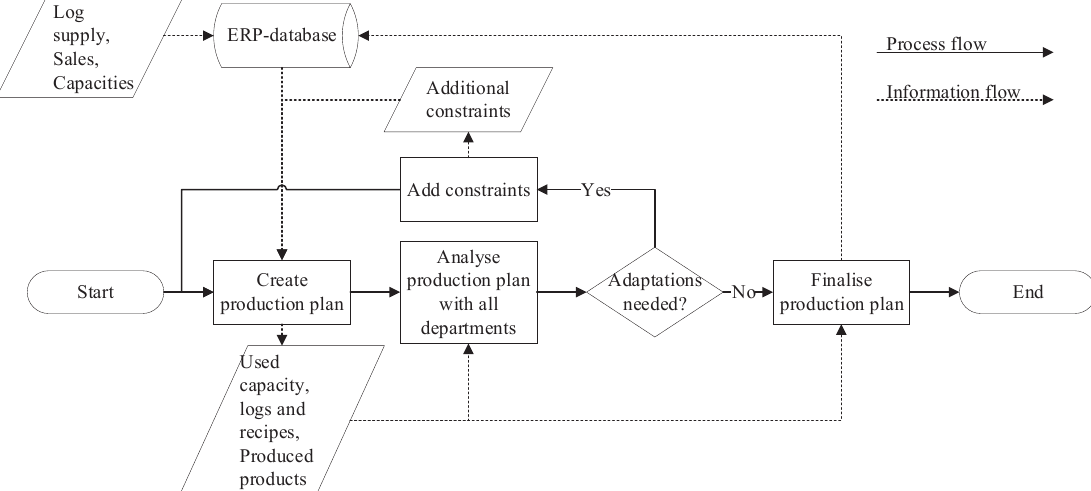
Figure 3. Illustration of the new workflow for the developed iterative planning process with process and information